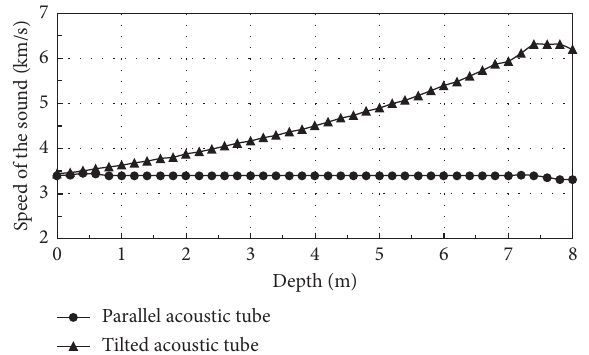
Figure 5: The results of the complete pile with the tilted acoustic tube and the parallel acoustic